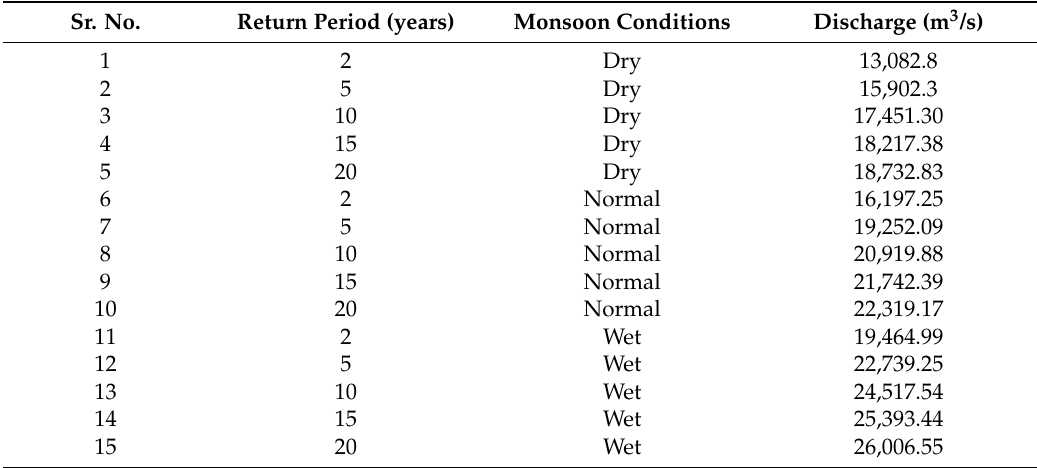
Table 3. Variation of discharge at the upstream nodal with monsoon condition and flow wave of different return periods